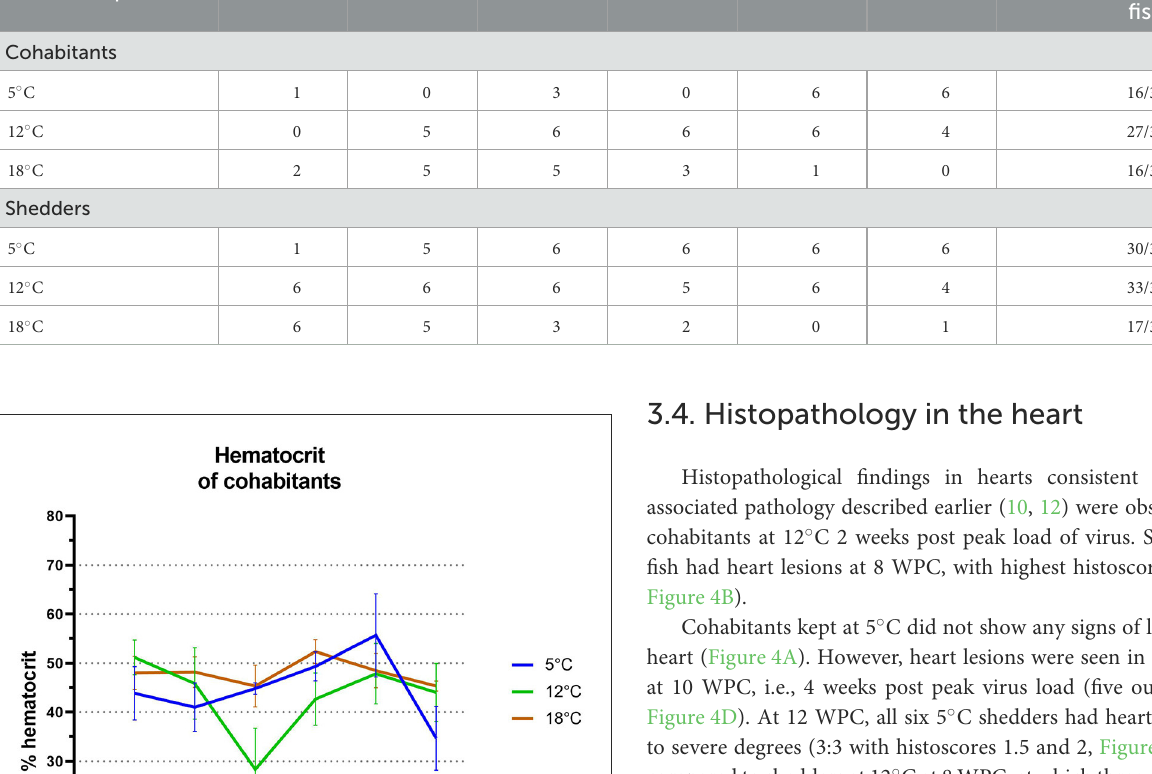
TABLE 4 Number of PRV-3 positive fish at a given time-point and temperature. WPC/ temperature